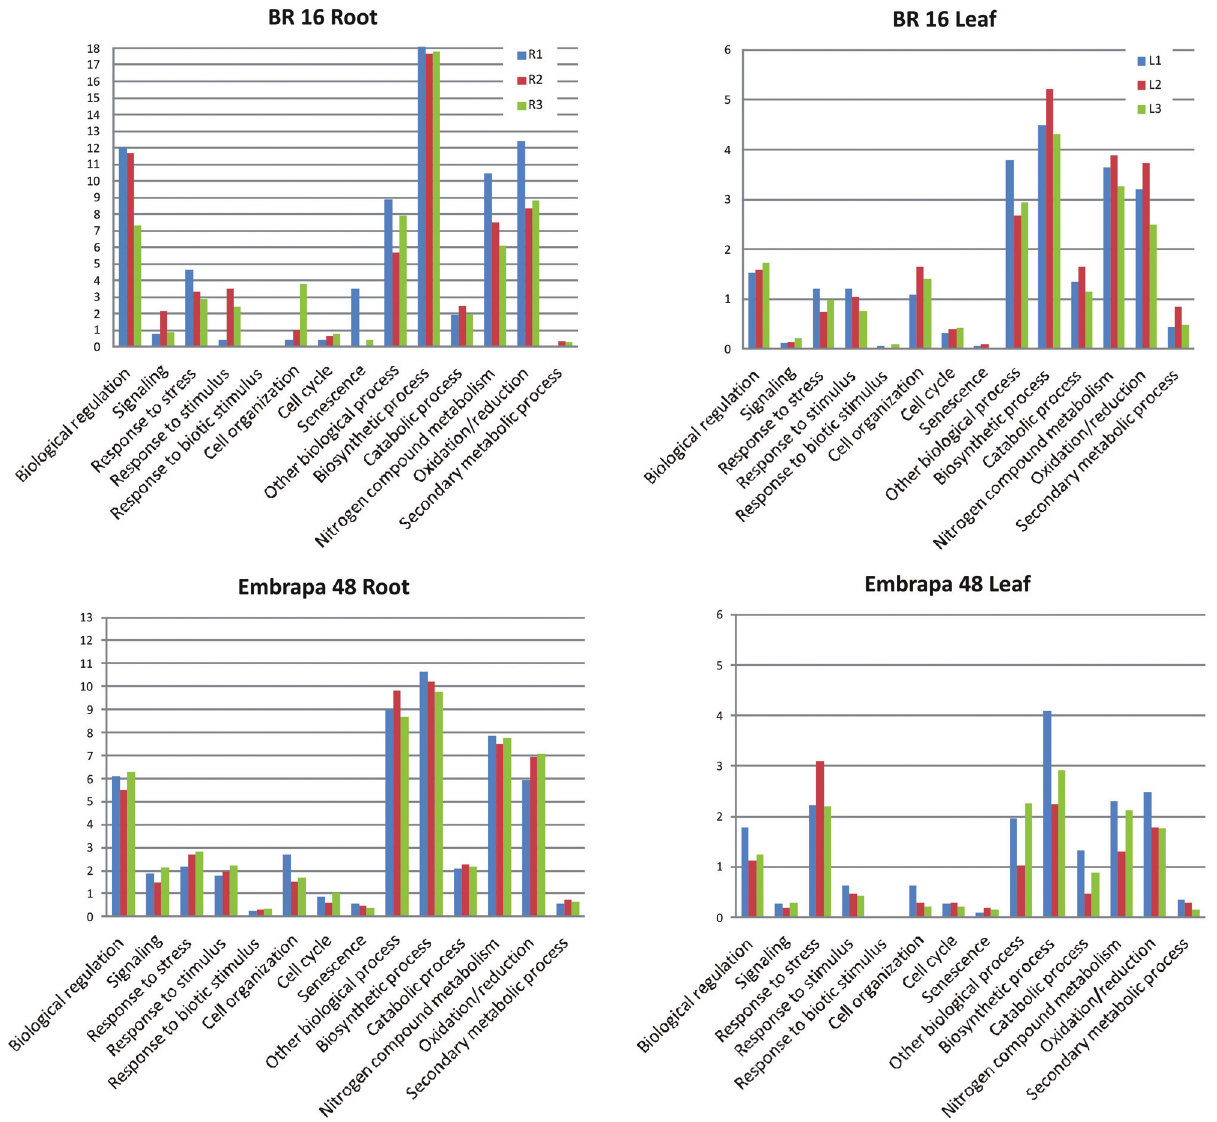
Figure 3 - Functional classification. The expressed genes were distributed in categories according to the Biological Process (level 3) of the Gene Ontol- ogydatabase.Categorieswerenormalizedthroughtheratiobetweenthenumberofgenespresentineachcategorybythenumberofgenesidentifiedinthe library. The Y axis represents the percentage (%) of genes